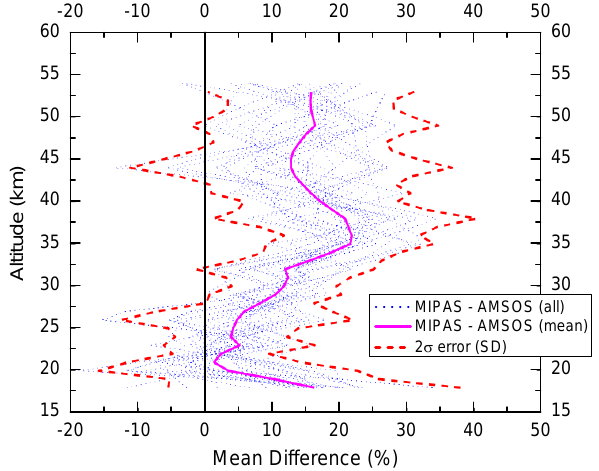
Fig. 12. Comparison between MIPAS and AMSOS H 2 O measurements for all available 28 direct collocations (mean difference: magenta solid line). Individual comparisons: blue dotted lines, 2 σ standard deviation: red dashed lines.